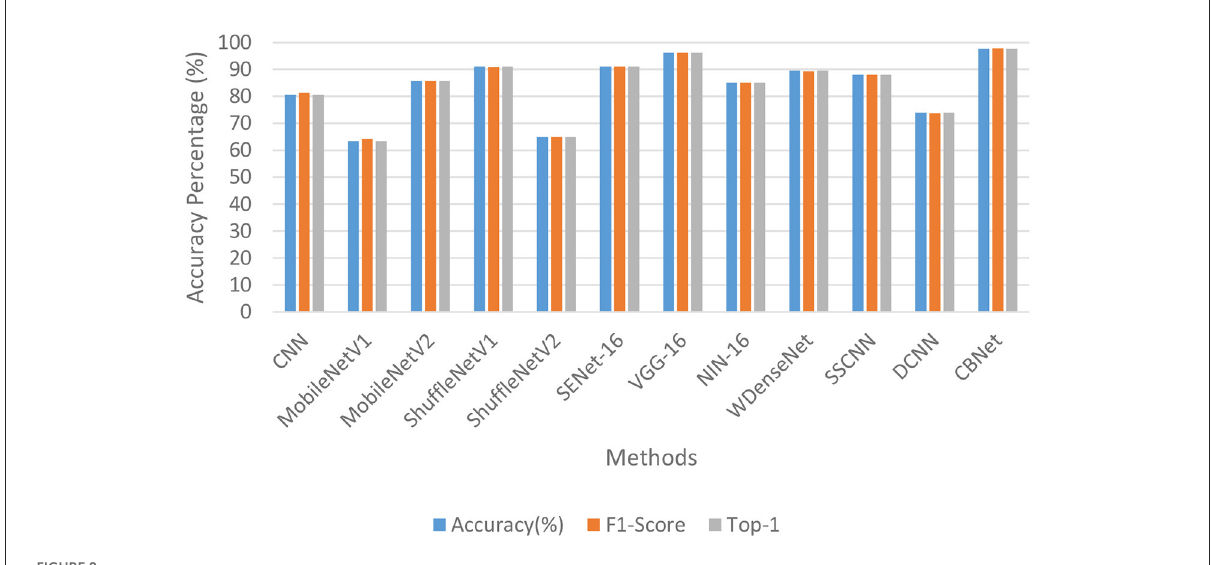
FIGURE8 Histogram comparing CBNet with other methods.